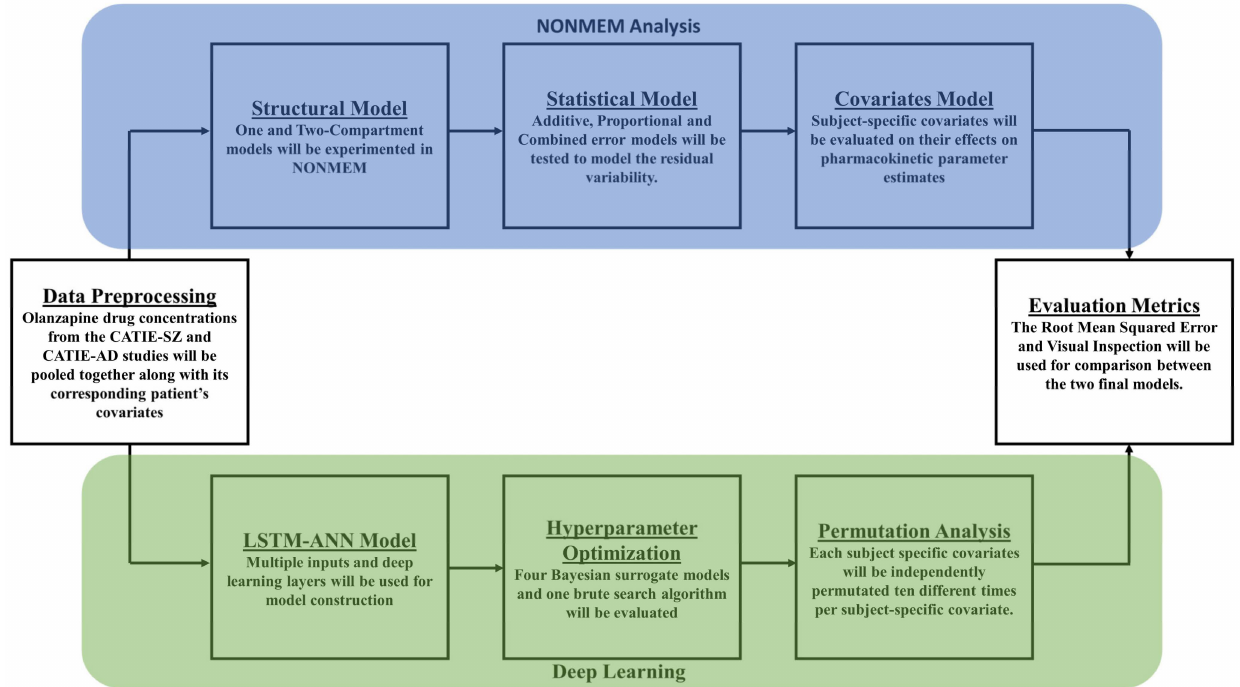
Figure 2. A flowchart showing model development for both the NONMEM analysis and the Deep Learning approach. The different colors correspond to the different modeling workflows. The blue represents the NONMEM analysis. Initially, a structural model was built, followed by a statistical model. Finally, a covariate analysis was completed. The green represents the Deep Learning approach. First, the LSTM-ANN model was built, followed by a hyperparameter optimization. Last, a permutation analysis was